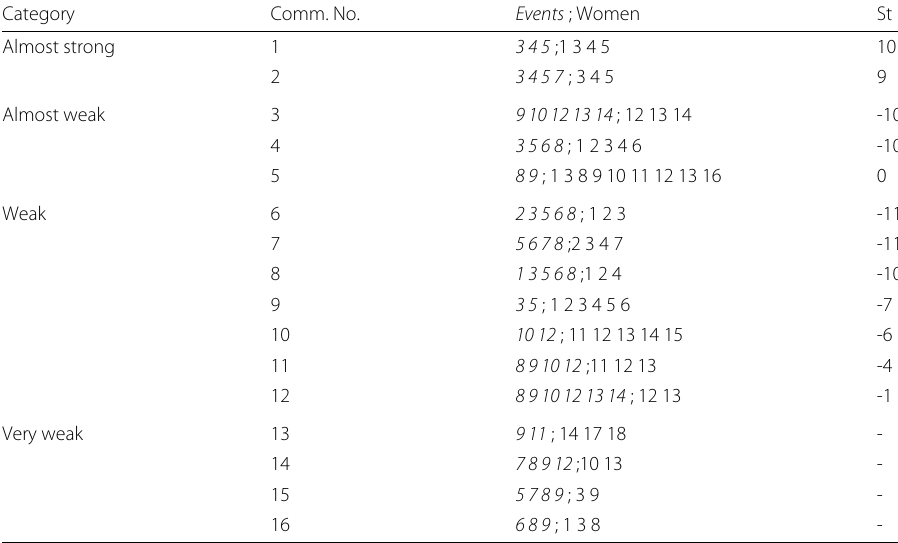
Table 1 The 16 metadata communities found by MaxBic in the Southern Women network Category Comm. No. Almost